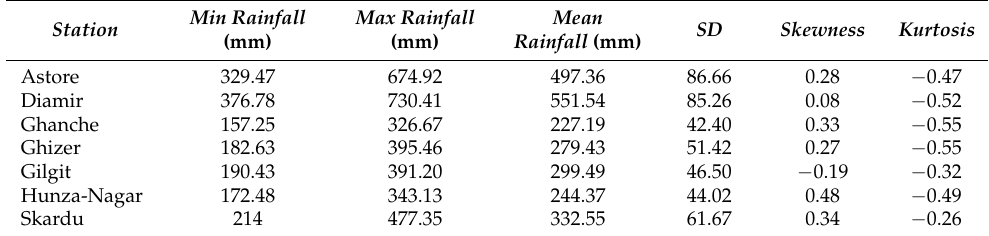
Table 3. Statistics of annual rainfall at the district level.